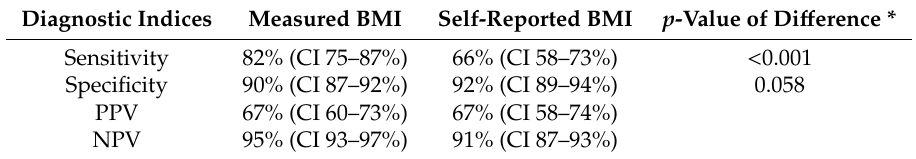
Table 2. The validity of overweight and obesity classification by measured BMI and self-reported BMI measured by several diagnostic